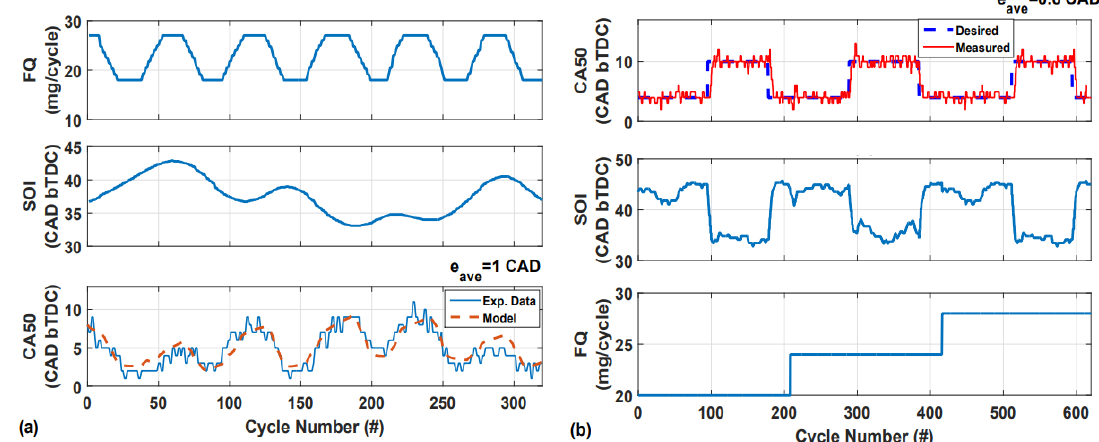
Figure 20. Implementation of LS-SVM based LPV-SS MPC to control RCCI engine. ( a ) The true output and prediction of CA50 using LS-SVM-based LPV-SS modeling approaches, ( b ) MPC control performance with variable fuel rate to track desired CA50 [21] (Reprinted from [204] with permission of